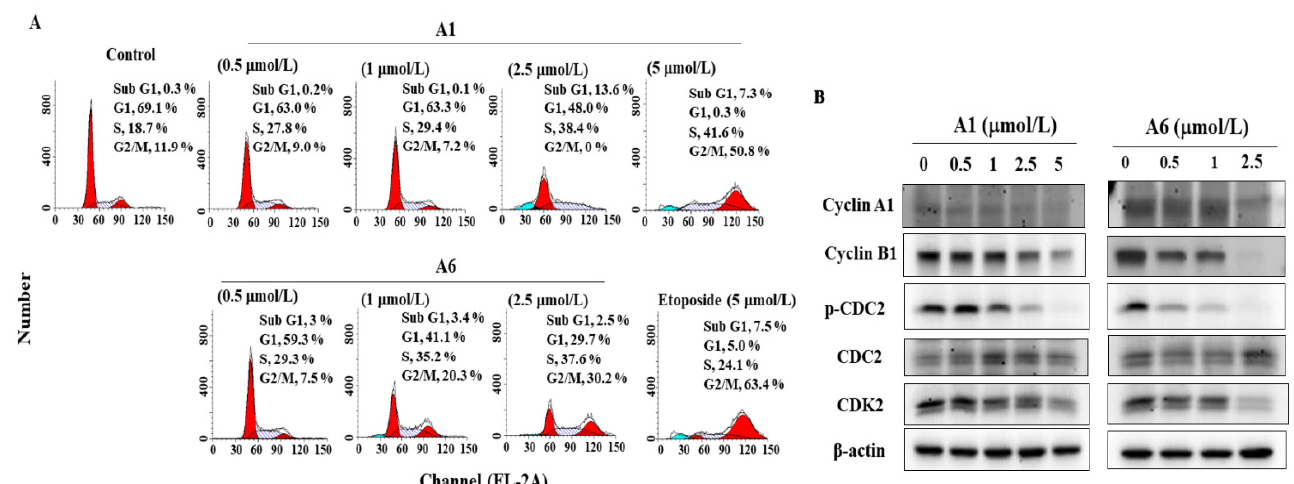
Figure 3. A1 and A6 induce cell cycle arrest. ( A ) Cell cycle analysis of A1- and A6-treated Hep3B cells for 48 h. Cell cycle population in each histogram was indicated. The first peak is the G1 phase and the second peak is the G2/M phase. Etoposide (5 µ mol/L) was used as a positive control. ( B ) Effects of A1 and A6 on the phosphorylation/expression of cyclin A1, cyclin B1, CDC-2, and CDK2 in Hep3B cells.